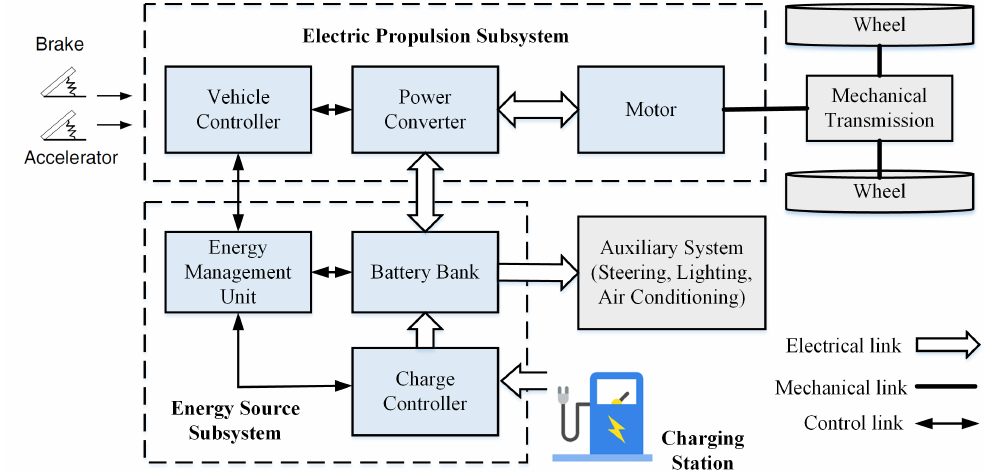
Figure 2. Schematic diagram of a typical plug-in electric vehicle (PEV) system.